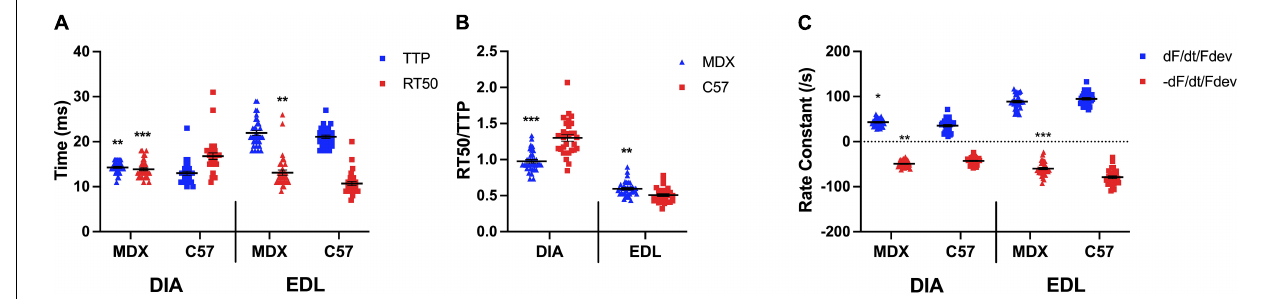
FIGURE 3 | (A) Time to peak and 50% relaxation of 52 week old dystrophic and wildtype muscle types. Kinetic analysis was conducted in diaphragm and EDL muscles from the same mice. Mouse models include dystrophic MDX and wildtype C57BL/10. Statistical analysis was conducted using a two-sided t -test. ** P < 0.01 and *** P < 0.001 compared to C57BL/10 mice. The line represents the group mean; error bars are standard error of mean. (B) 50% relaxation of 52 week old dystrophic and wildtype muscle types. Mouse models include dystrophic MDX and wildtype C57BL/10. Statistical analysis was conducted using a two-sided t -test. ** P < 0.01 and *** P < 0.001 compared to C57BL/10 mice. The line represents the group mean; error bars are standard error of mean. (C) Rate constants of individual diaphragm and EDL twitches. Mouse models include dystrophic MDX and wildtype C57BL/10. Statistical analysis was conducted using a two-sided t -test. * P < 0.05, ** P < 0.01, and *** P < 0.001 compared to C57BL/10 mice. The line represents the group mean; error bars are standard error of mean.